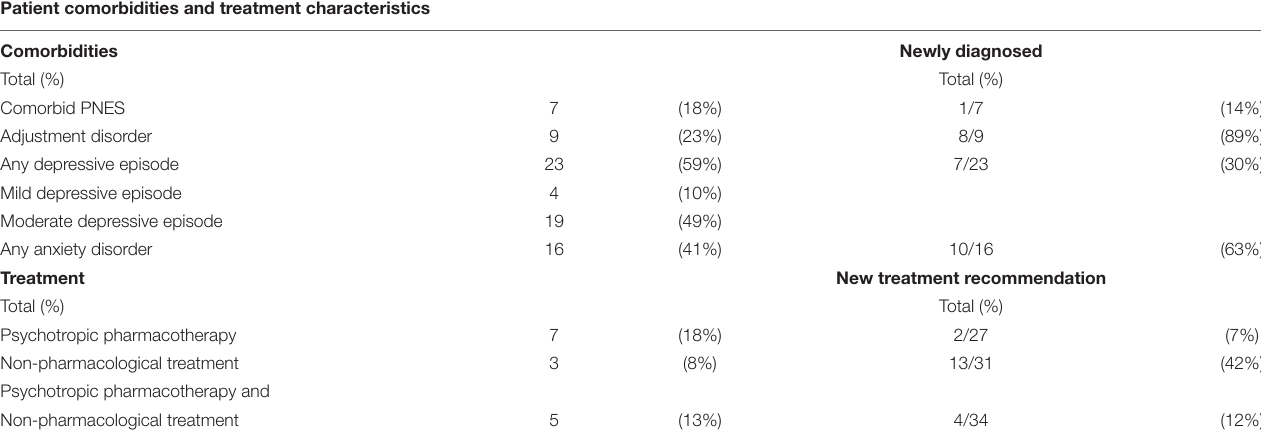
TABLE 2 | Psychiatric comorbidities and treatment characteristics of epilepsy patients with psychiatric comorbidity. Patient comorbidities and treatment